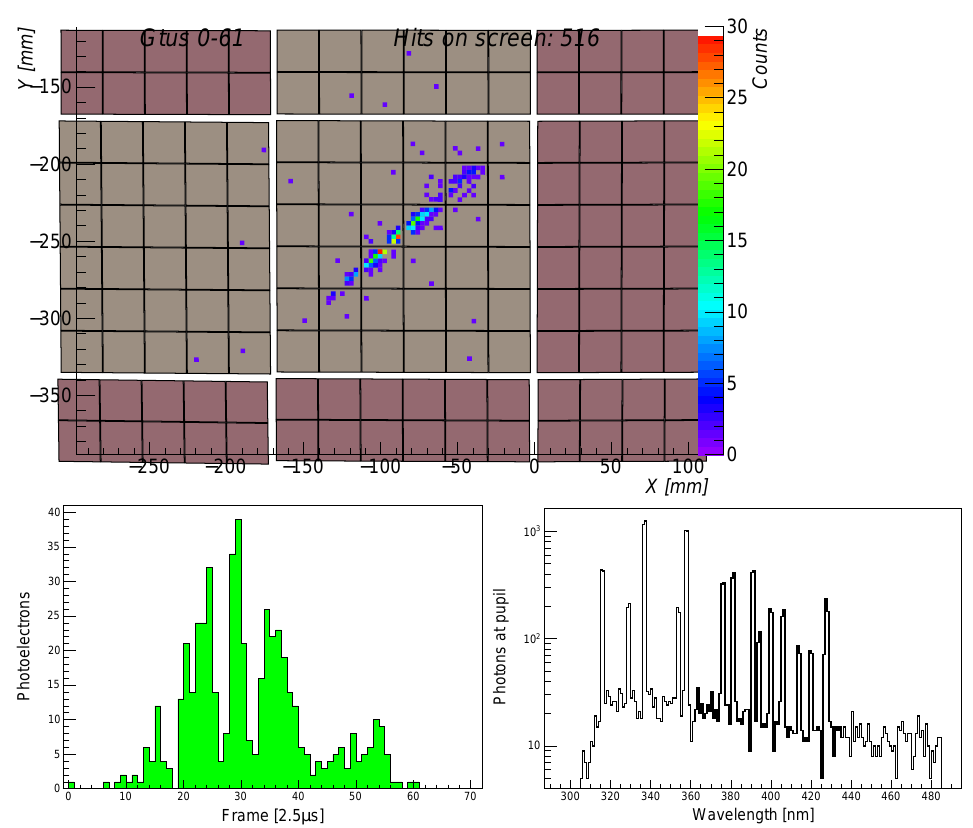
Figure 10. Distribution of photoelectrons from an EAS generated by a 100 EeV proton arriving at the zenith angle of 60 ◦ simulated with ESAF. Only signal from the shower is shown. ( Top ): distribution of the signal on the focal surface. ( Bottom left ): the corresponding time distribution of photoelectrons. ( Bottom right ): the spectrum of photons at the detector